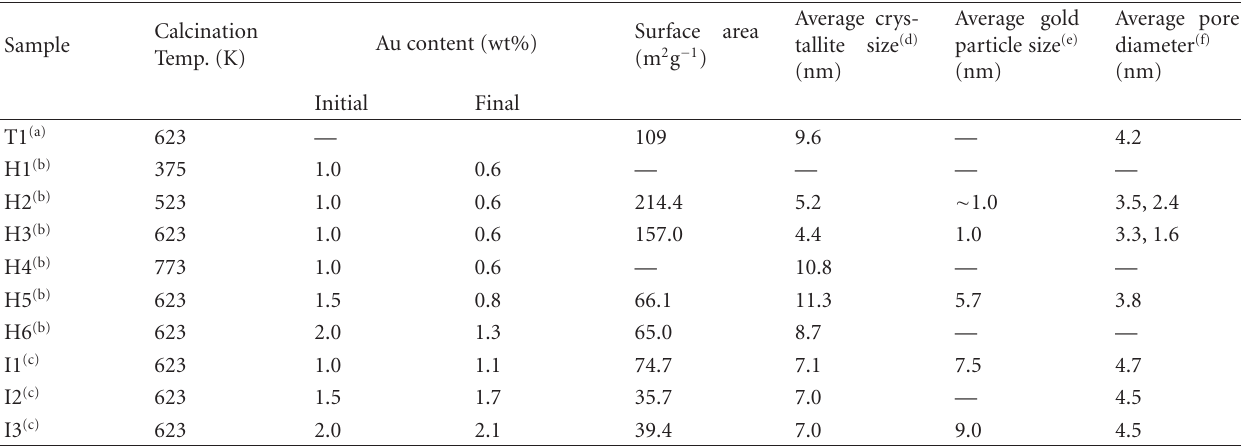
Table 1: Physical properties of TiO 2 and Au/TiO 2